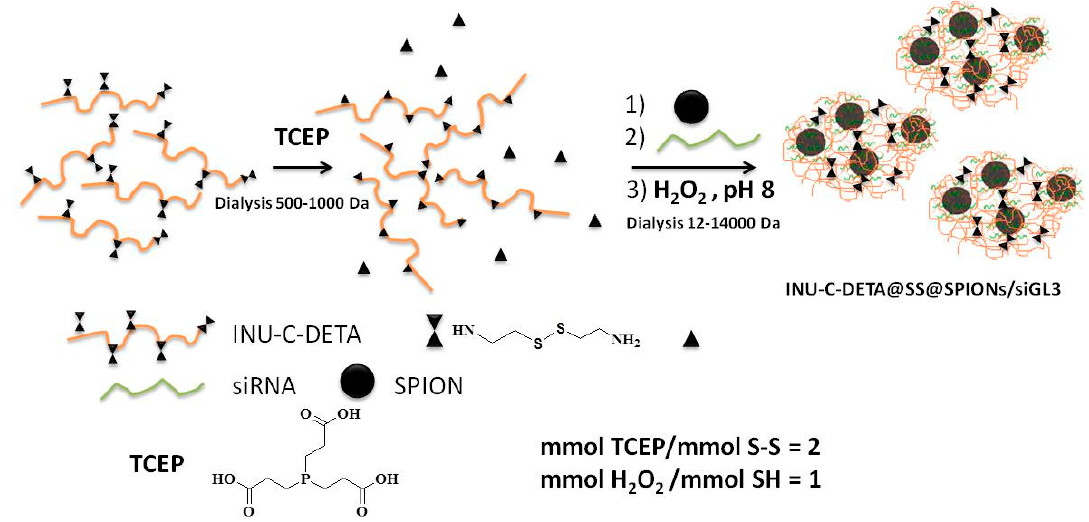
Figure 4. Schematic representation of ICD@SS@SPIONs/siRNA preparation.